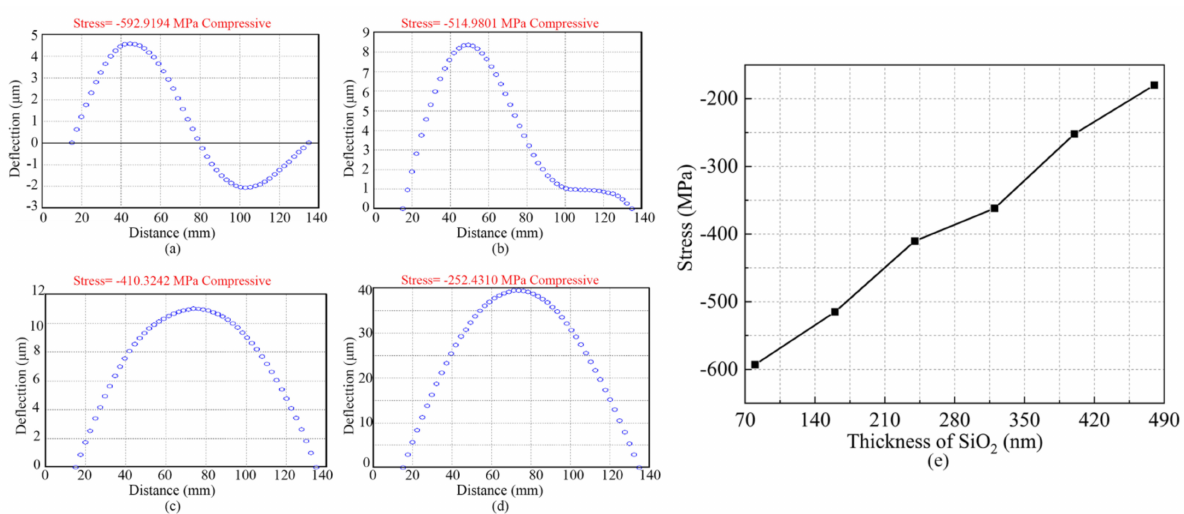
Figure 7. Stress of the SiO 2 films with different thicknesses: ( a ) 80, ( b ) 160, ( c ) 240, and ( d ) 320 nm. ( e ) Stress with different SiO 2 thicknesses.